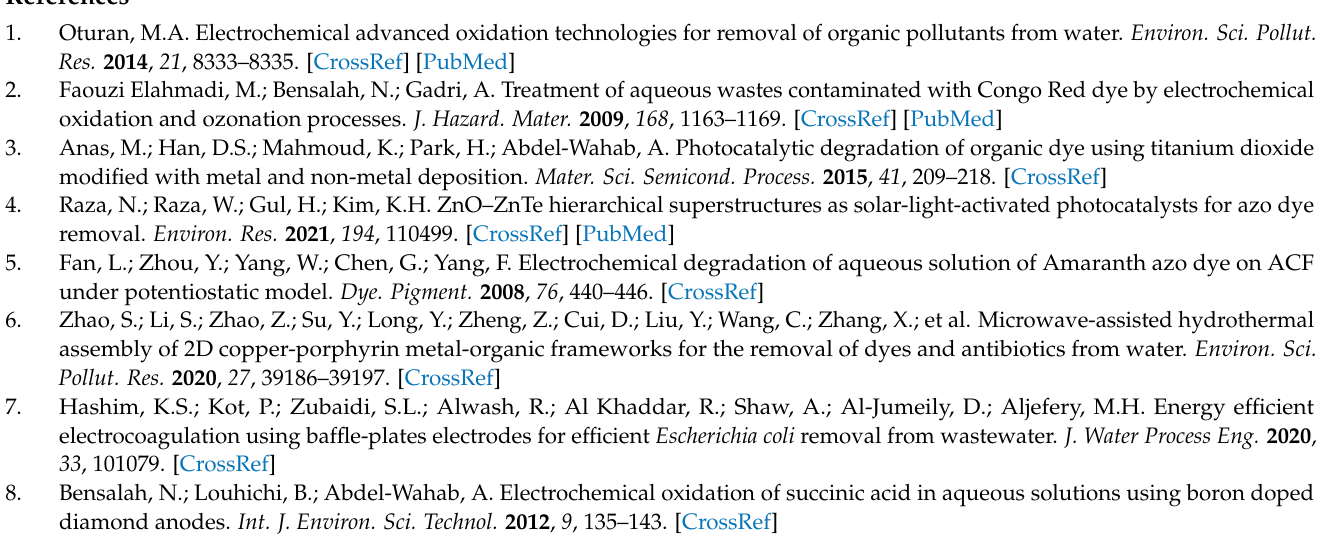
catalyst in 20 µ M coumarin before and after the test. Figure S11: Detection of HClO by DPD method. Figure S12: MS measurement of H 2 and O 2 gas during the RhB degradation. Text S6: Degradation mechanism of RhB dye. Text S7: Calculation of the current generation efficiency of HClO. Figure S13: LSV plots and SEM images of Fe 2 P-iron phosphate electrode recorded before and after the recycling test. Figure S14: HPLC of 1 × 10 –5 M RhB solution in the presence of NaCl, NH 4 Cl and Na 2 SO 4 . Text S8: Phytotoxicity test using Lepidium sativum L . Figure S15: Images of Lepidium sativum L. incubated in Petri dishes with RhB before and after EC treatment. Figure S16: LSV of Fe 2 P-iron phosphate catalyst in NaCl seeded with 1.1 × 10 8 CFU/mL of E. coli bacteria and I - t plot obtained in 0.06 M NaCl + 1.1 × 10 8 CFU/mL of E. coli at 2.0 V vs. RHE. Table S2: Selected materials used in EC degradation of different dye molecules. Table S3: Selected materials used in EC inactivation of E.coli bacteria. Text S9: Synthesis and characterization of Fe 2 P thin film. Text S10: Catalyst evaluation. Figure S17: Photograph of the cappuccino cell and EC cell used in the dye degradation studies. Table S4: Characteristics of RhB dye. [67–92] are cited in the Supplementary